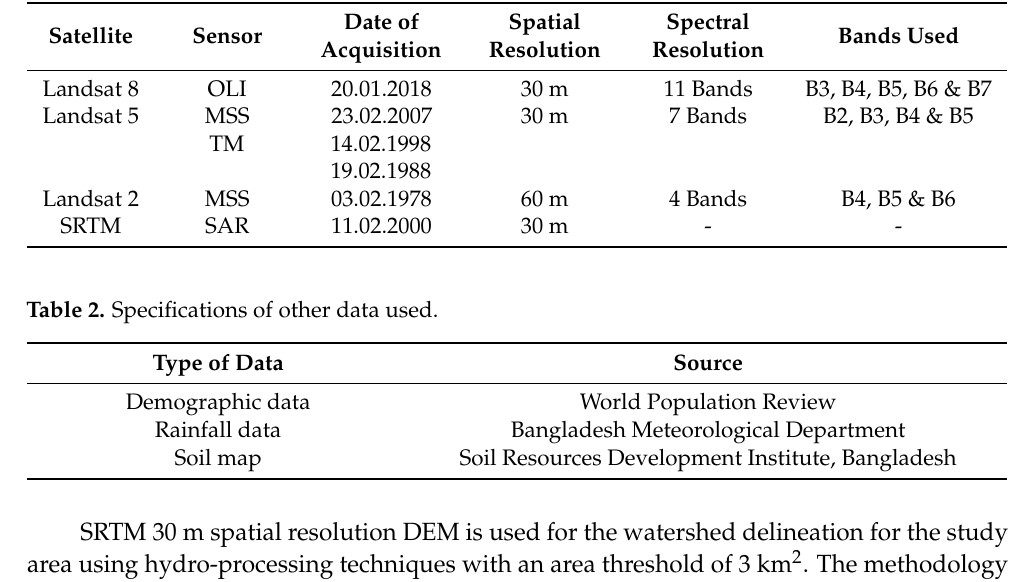
Table 1. Specifications of satellite data used.